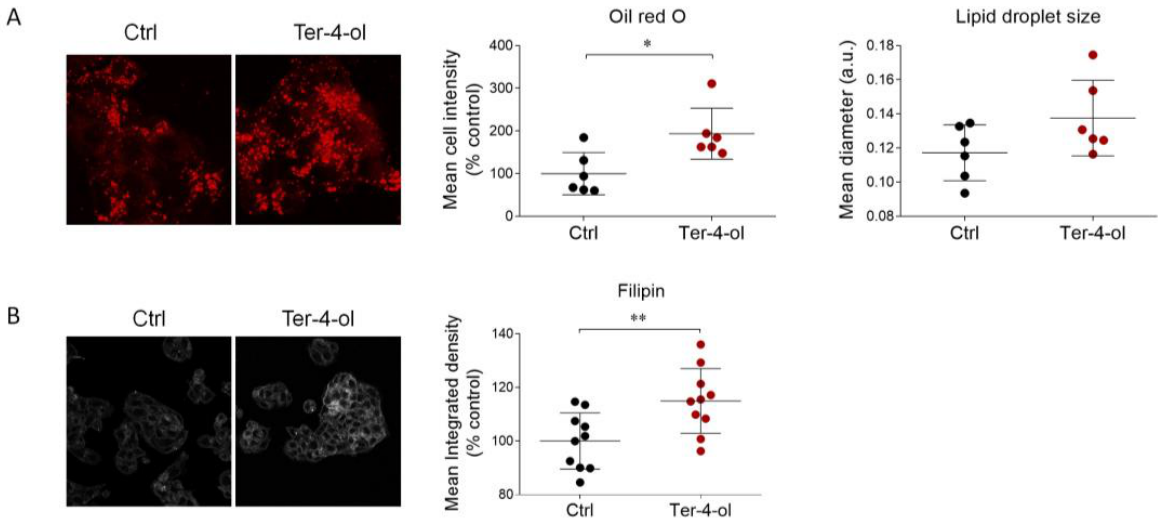
Figure 6. Effects of terpinen-4-ol on neutral lipids and free cholesterol. ( A ) Representative images (left) and respective quantification of the signal intensity and estimation of lipid droplet size (right) following Oil Red O staining performed on the vehicle- (DMSO) and terpinen-4-ol-treated (0.00034%) HepG2 cells for 24 h. n = 6 independent experiments. ( B ) Representative images and quantitative analysis of filipin staining detected in HepG2 cells stimulated as in ( A ). n = 10 different experiments. Data represent means ± SD. Statistical analysis was performed using the unpaired Student’s t -test. * p < 0.05; ** p < 0.01.